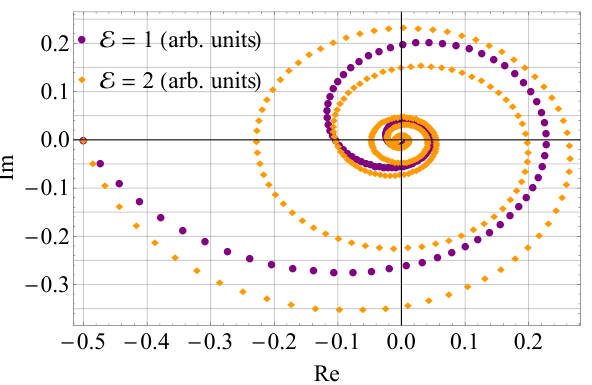
( t ) , presented on the complex plane for two values of E . Figure 2. Trajectories of the phase factor, ρ AB 14 Furthermore, we investigate how the amount of entanglement changes over